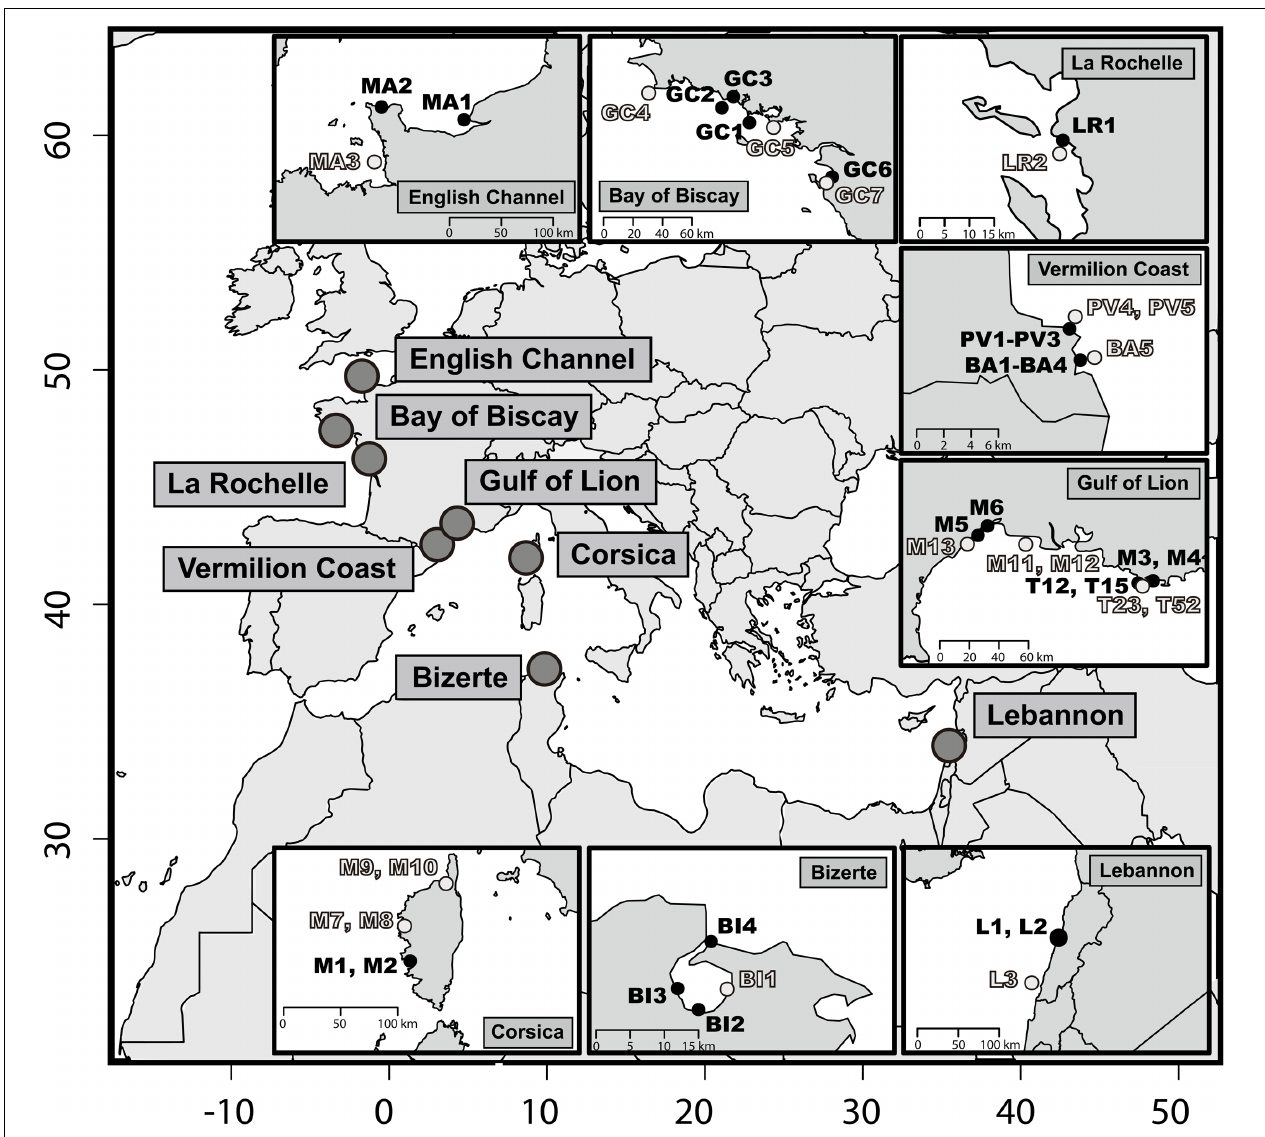
FIGURE 1 | Map of the 46 sediments sampling stations. At each location a priori non-contaminated sites are in light gray and a priori contaminated sites in black. The x -axis and y -axis stand for decimal longitude and latitude,